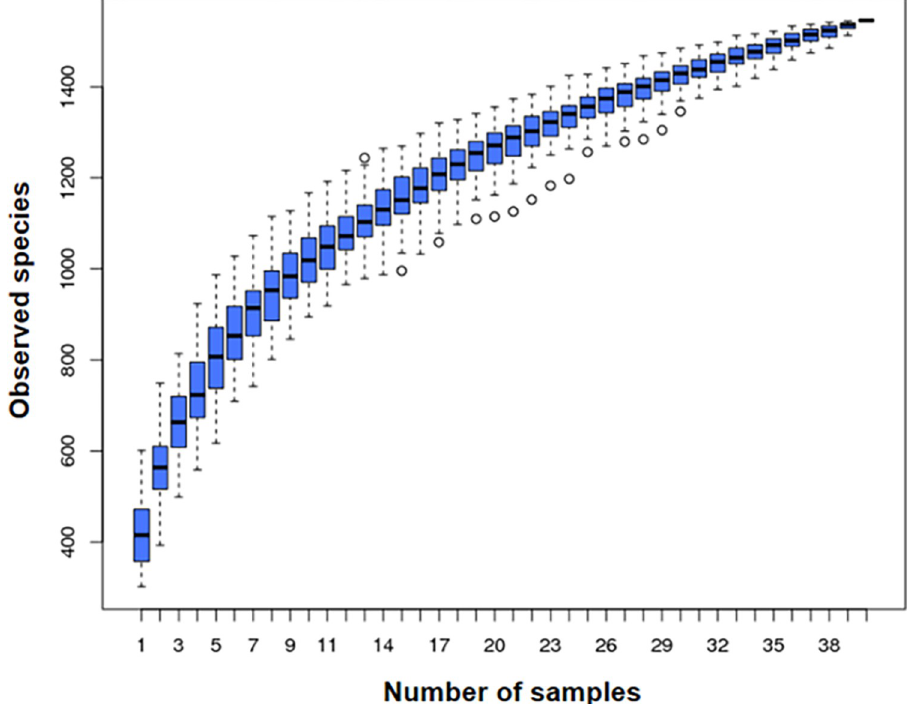
Fig 1. Species accumulation curve. X-axis: Number of samples, Y-axis: number of OTUs. Following an initial sharp rise in the number of OTUs as number of samples increases, there is a levelling of the plot. The narrow spread of the boxplots as the total number of samples is approached indicates that the number of samples was adequate to capture most of the microbial diversity present.